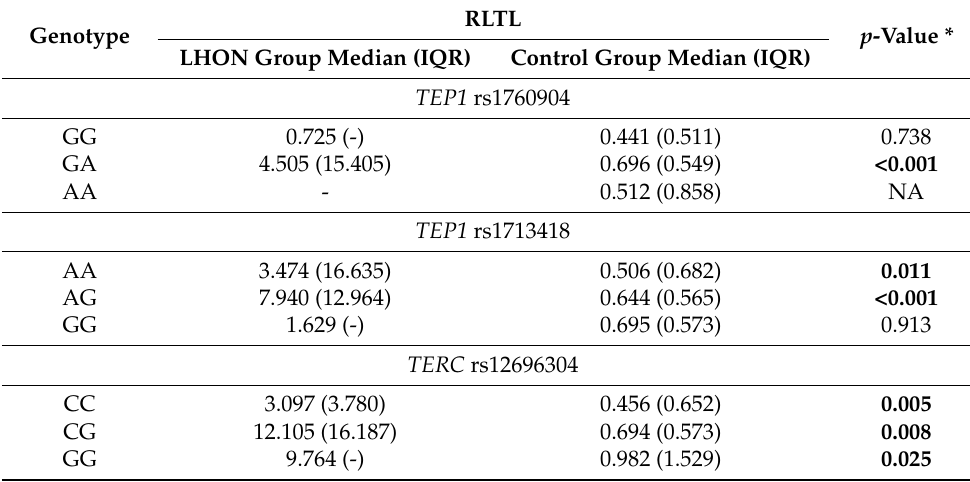
Table 4. Distribution of relative leukocyte telomere lengths by